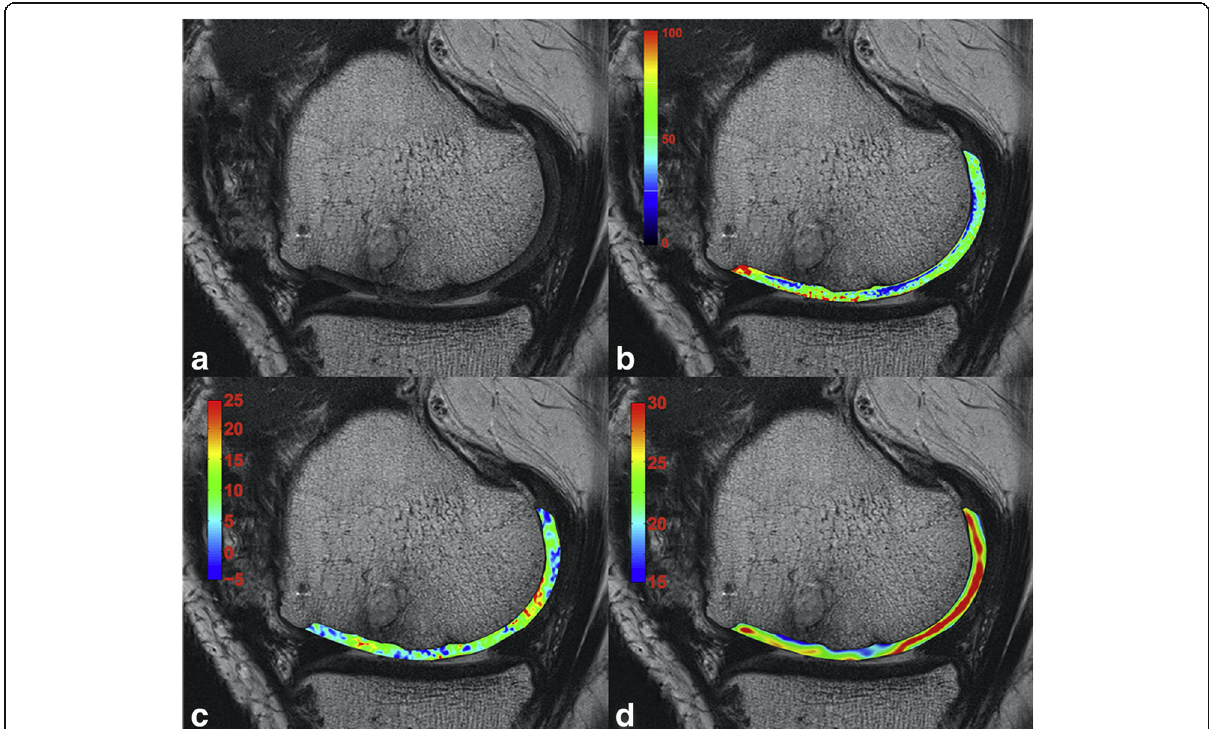
Fig. 5 7-T MRI of a patient (mean age of subjects included: 49 years old; interquartile range, 44 – 55) 8 years after osteochondral treatment at the medial femoral condyle. a Morphologic proton-density fast spin-echo image. b Graphical overlay with T2 map. Colour bar represents relaxation times (ms) (higher values, more water and disturbed collagen architecture). c Graphical overlay with glycosaminoglycan chemical exchange saturation transfer (gagCEST) image. Colour bar represents gagCEST asymmetries in % (lower values, less proteoglycan content). d Graphical overlay with sodium image. Colour bar represents the sodium signal-to-noise ratio values (lower values, less proteoglycan content). Reprinted with permission from: Krusche-Mandl et al., Osteoarthr Cartil 2012 (reference